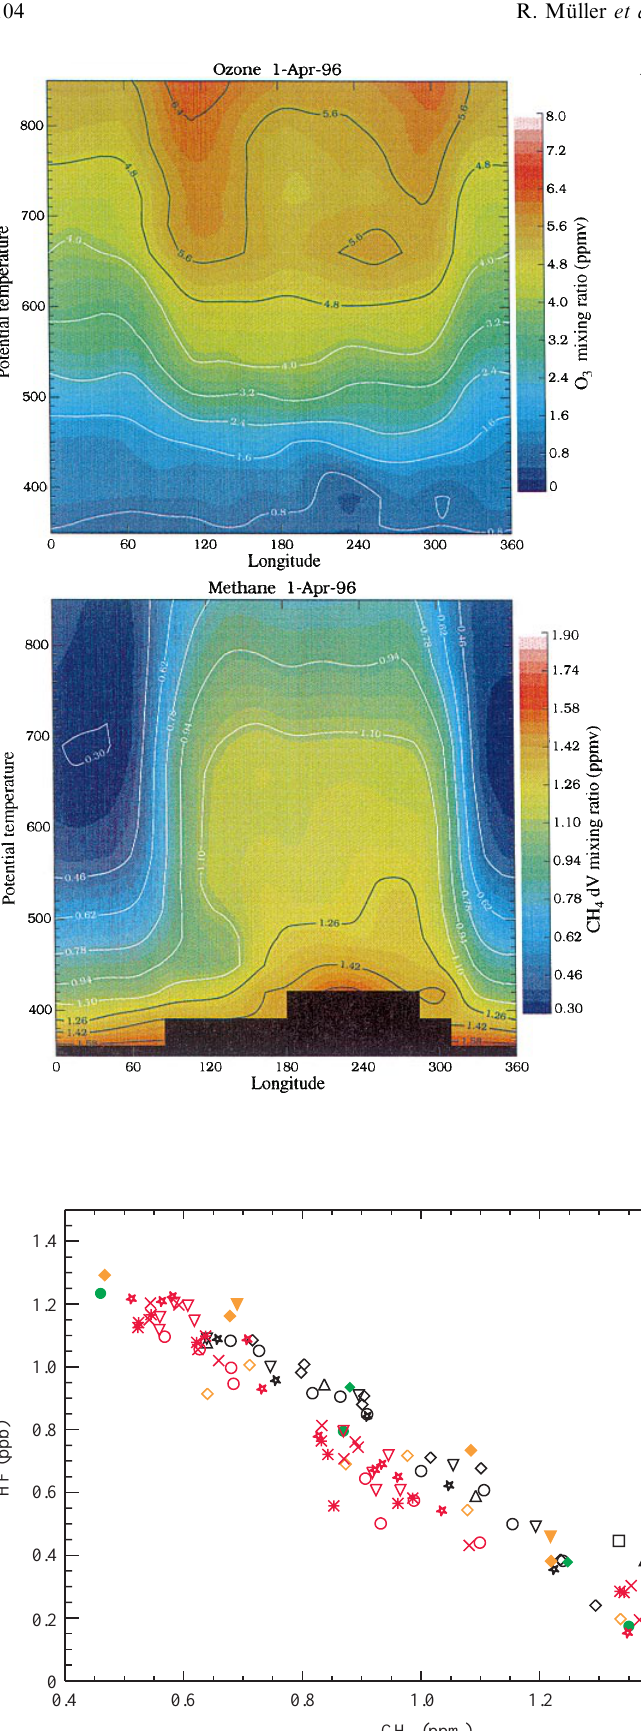
Fig. 5. As Fig. 2 but for sunset observations on April 1, 1996 (uarsday 1664), at 70 (cid:14) N. Vortex air is discernible over the whole altitude